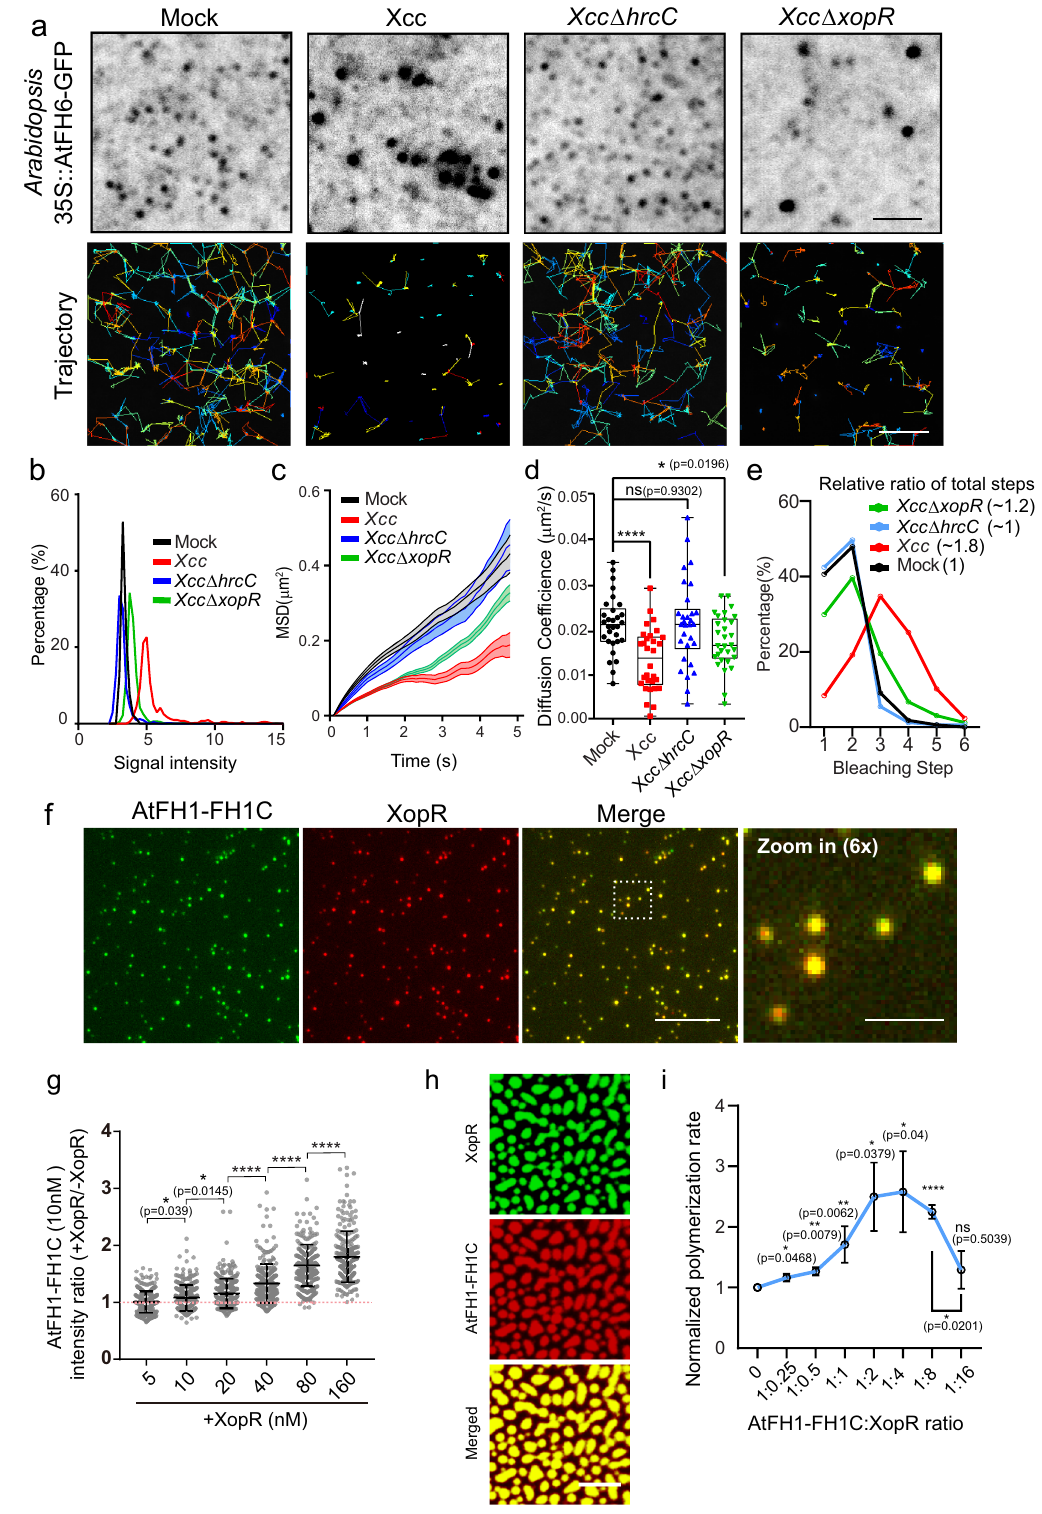
VA-TIRFM. At 24 h after Xcc inoculation, a large portion of AtFH6-GFP proteins was concentrated into brighter and larger nanoclusters from the small puncta that were displayed in the uninfected Arabidopsis (Fig. 3a, b). Via single-particle tracking and rheology analysis, AtFH6-GFP puncta showed heterogeneous dynamics on the cell surface. The primarily diffusive movement of AtFH6-GFP in untreated seedlings became a con fi ned